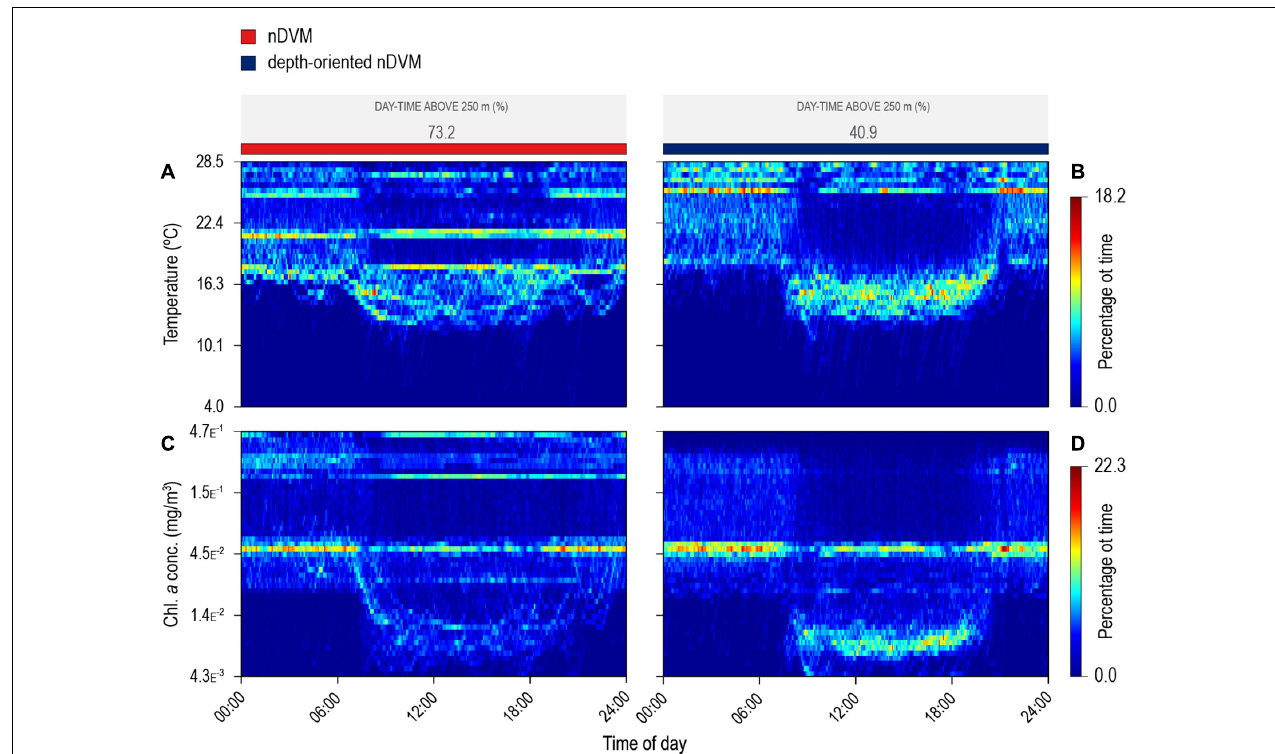
FIGURE 5 | Blue shark habitat-use for a 24 h period, during nDVM on the left (A,C) and depth-oriented nDVM on the right (B,D) . Time-at-temperature (A,B) ; and time-at-chlorophyll a (C,D) . Coloured bar above represents the identified diel behaviour.